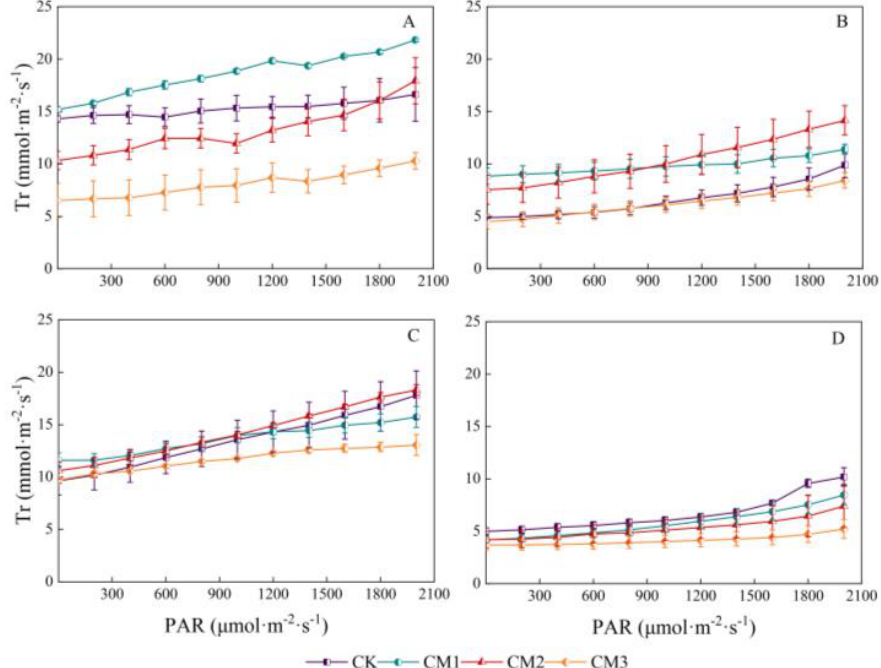
Figure 6. Light-response curves of cotton transpiration rate (Tr) under different configuration modes. ( A ): seedling period; ( B ): budding period; ( C ): flowering and boll development period; ( D ): maturation period.